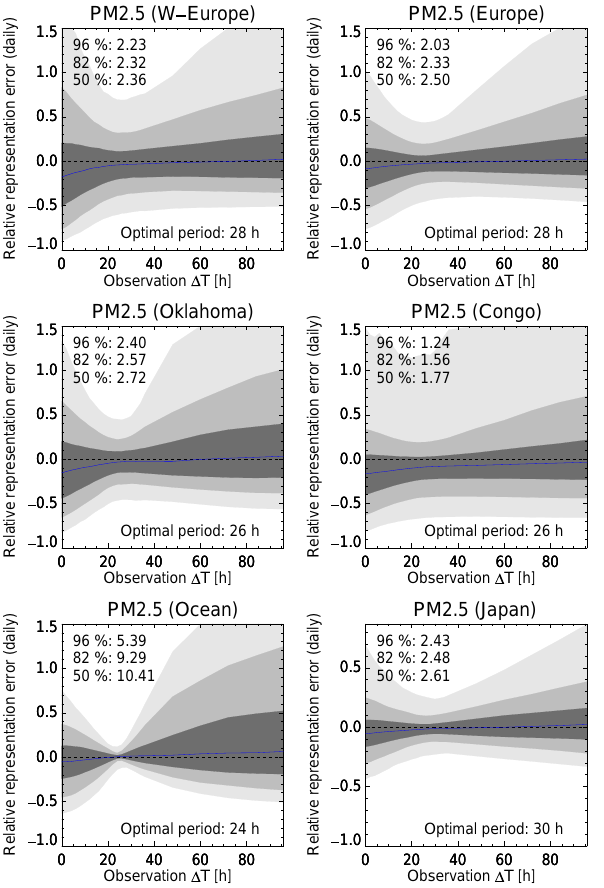
Figure 22. Hourly representation errors as a function of averaging period (cid:49)T used for surface PM 2 . 5 observations. In the top-left cor- ner of each panel, the ratios of q 98 – q 2 , q 91 – q 9 and q 75 – q 25 for (cid:49)T = 0 to optimal (cid:49)T are given. Results for a 210 × 210km 2 grid box. Further explanation in Sect. 3.2.